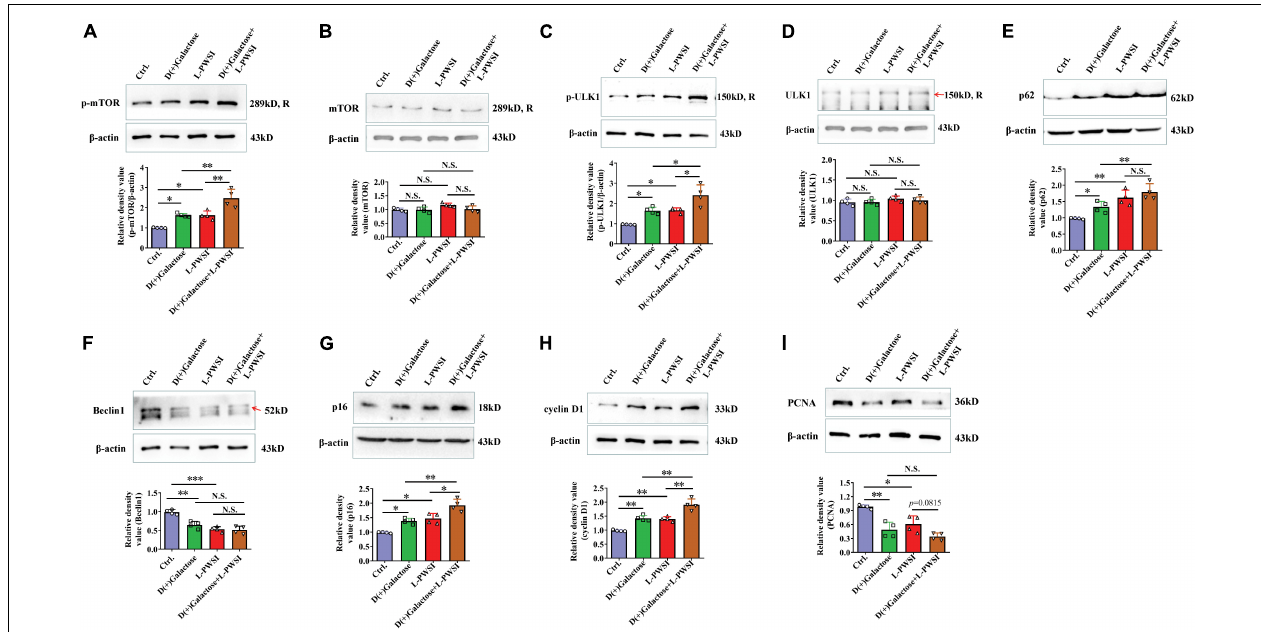
FIGURE 6 | Treatment with long-term post-weaned social isolation (L-PWSI) and D(+)Galactose altered autophagy and cell-cycle molecules. Representative micrographs of Western blot (protein expression) with densitometry analysis of (A) phosphorylated mammalian target of rapamycin (p-mTOR), (B) mTOR, (C) p-ULK1, (D) ULK1, (E) p62, (F) Beclin 1, (G) p16, (H) cyclin D1, and (I) PCNA in the hippocampus. The grouping of gels/blots is cropped from different parts of the same gel. Each data column represents the mean ± SEM obtained from four brain samples. ∗ represents p < 0.05; ∗∗ represents p < 0.01; ∗∗∗ represents p < 0.001; N.S., represents no significance.